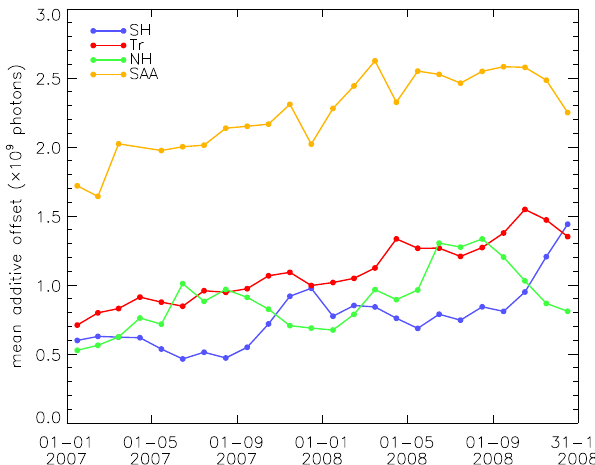
Fig. 13. Time series of the monthly mean additive offset for GOME-2 for 2007 and 2008. The data for the South Atlantic Anomaly (SAA) time series are not included in the time series for the Southern Hemisphere (SH), tropics (Tr) or Northern Hemi- sphere (NH).